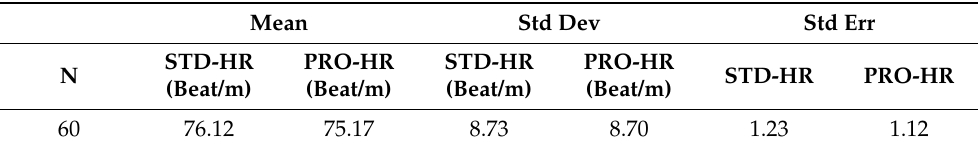
Figure 9. The comparison of measured heart rate results between the proposed smart device and the standard medical equipment (IOS Smart Watch): ( a ) the overlay plot; ( b ) the comparison plot. Table 1. The descriptive statistics of the heart rate results.